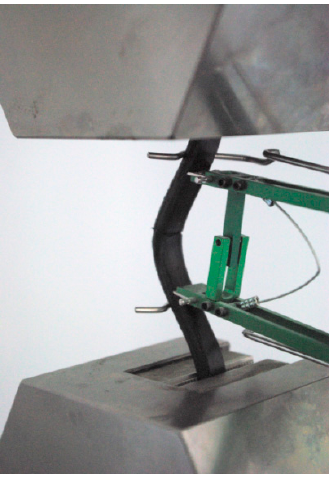
Figure 12. Diagram stress-strain for traction test, pipe Ф 90 × 6.